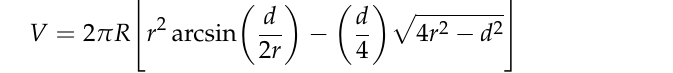
after 30 s intervals, thus resulting in a total of 444